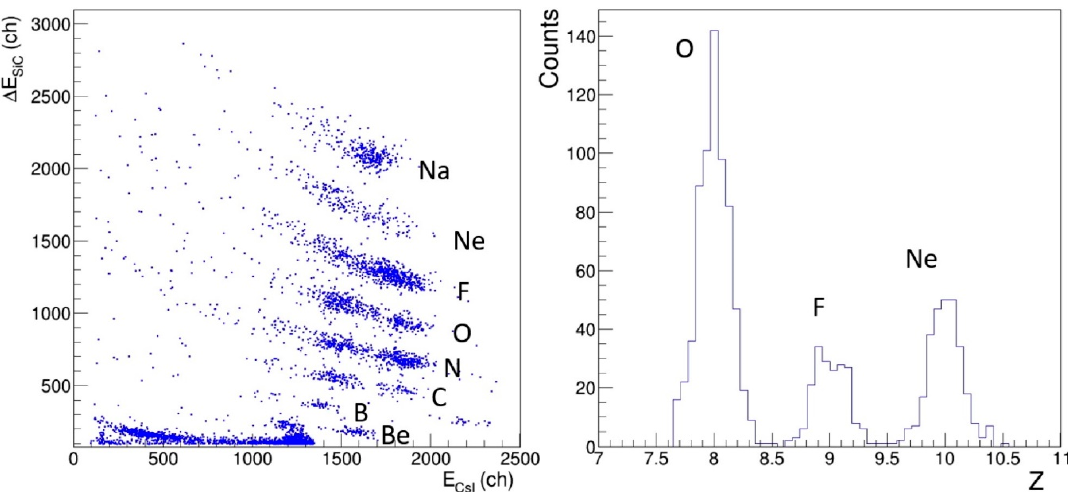
Figure 24. Left : ∆ E − E r plot like where the atomic number of the ejectiles can be determined. Right : distribution of a few ejectiles close to oxygen as a function of their atomic number, following a linearization and projection procedure.